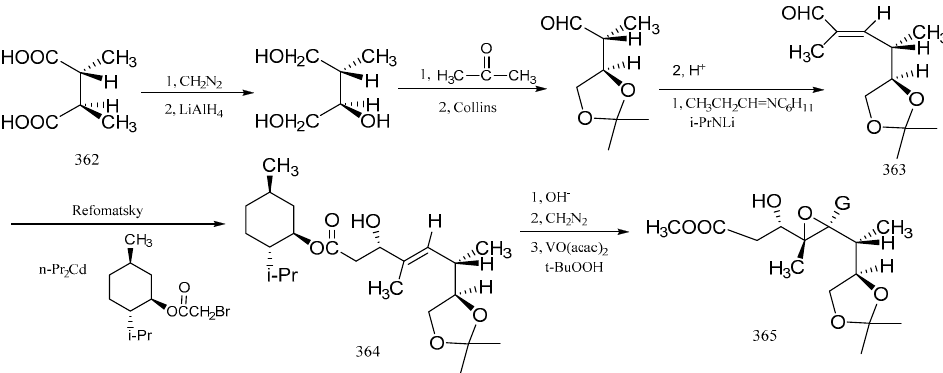
Figure 21. Stereo-selective synthesis of the derivatives from the C1–C8 fragment of maytansine.